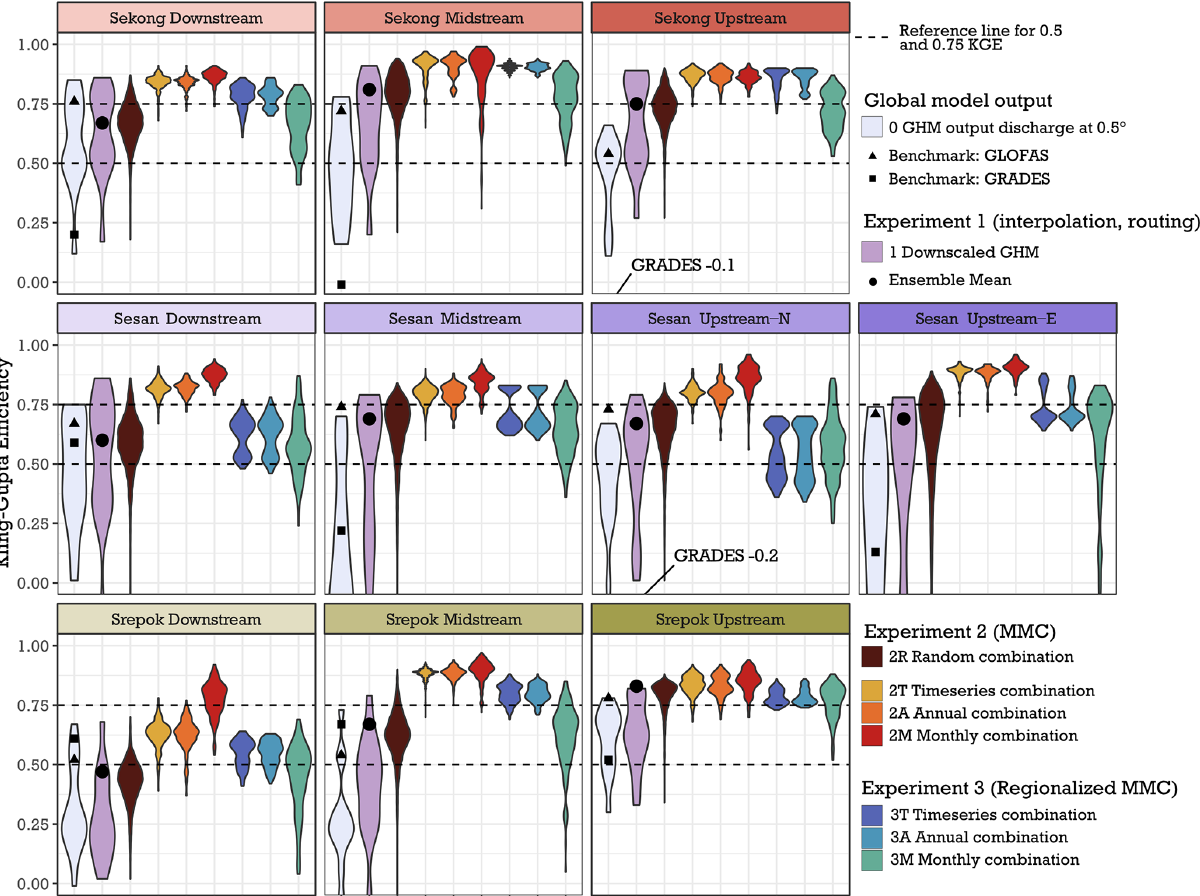
Figure 3. Comparison of Kling–Gupta efficiency compared to observed streamflow from the MRC for global model output and three ex- periments. Global model output: discharge from ISIMIP GHMs at 0.5 ◦ resolution ( n = 15), with results from benchmark products. Ex- periment 1: downscaled ISIMIP runoff. Experiment 2: multi-model combination (MMC) derived from random combinations and the three sampling strategies for CLS (i.e. constrained least squares; see Table 1) model averaging (2T, 2A, 2M). Experiment 3: using regionalised MMC weights derived in Experiment 2 at the gauges in the same river (Sekong, Sesan, or Srepok). KGE is shown for the testing period for Experiments 2 and 3 and for the entire time series for GHM discharge and Experiment